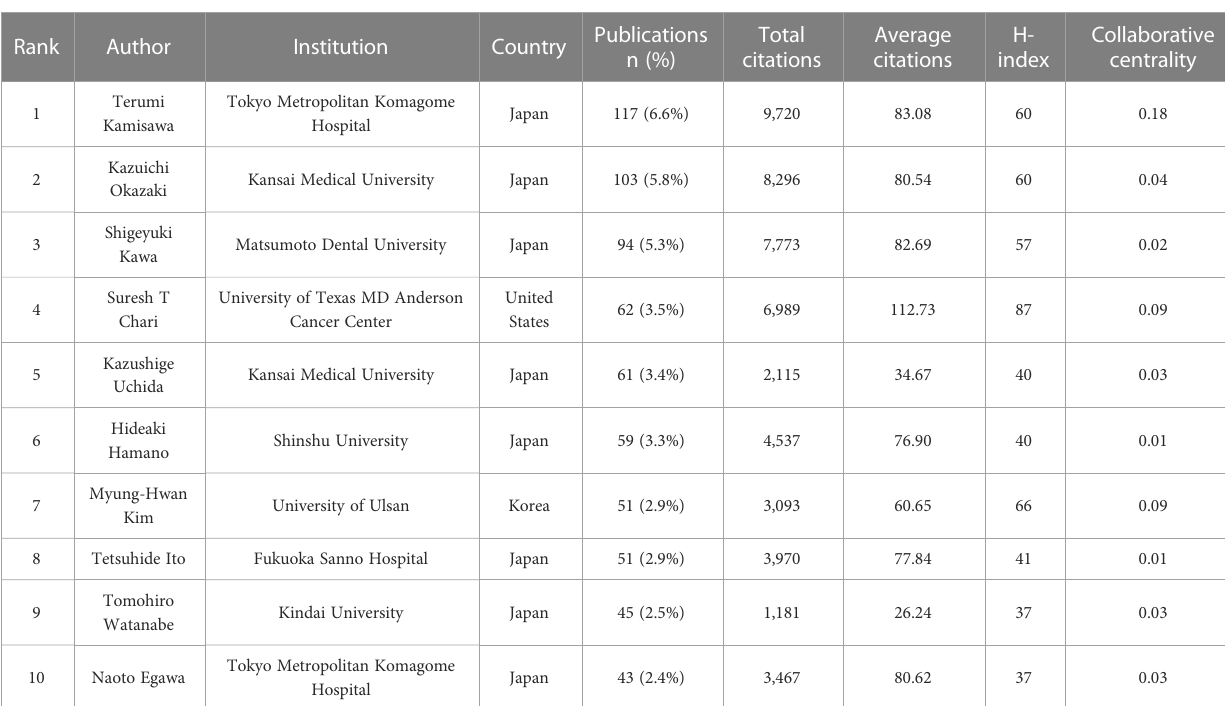
TABLE 3 The top 10 most productive authors in terms of AIP